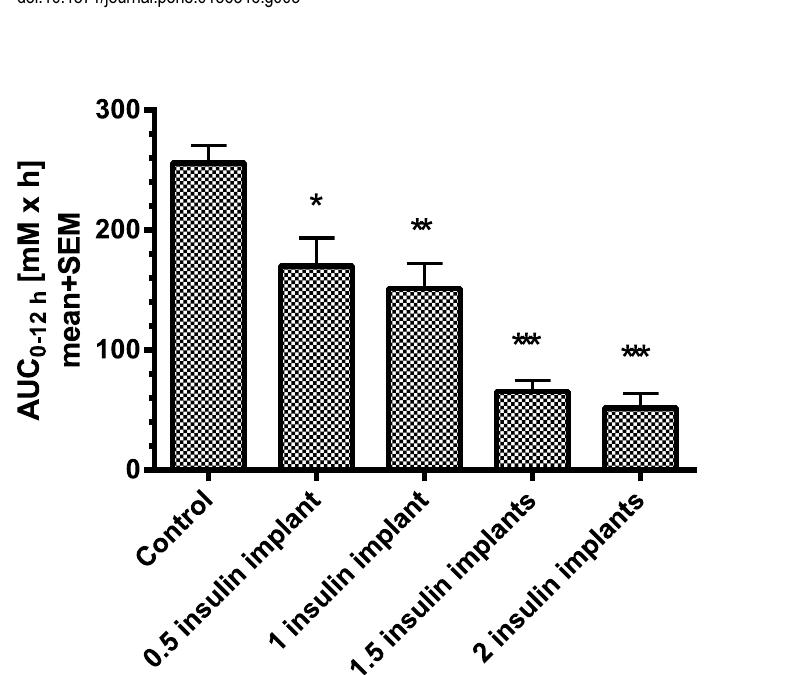
Fig 3. Blood glucose profile in STZ-diabetic rats 10 days after implantation of insulin implants (0.5, 1, 1.5, 2 implants/animal); normoglycemia is indicated by the dotted line. * p < 0.05, ** p < 0.01, *** p < 0.001 vs. control.